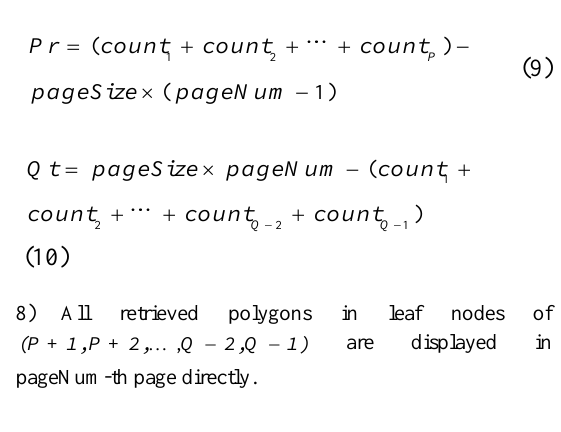
from Redis. Calculate the total number of retrieved polygons by formula